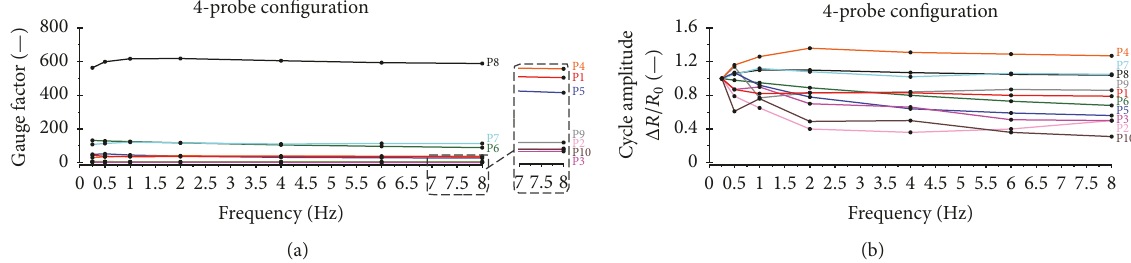
Figure 10: Plots of GF (a) and of normalized resistance variation (b) with increasing frequency of applied load using the four-probe method.